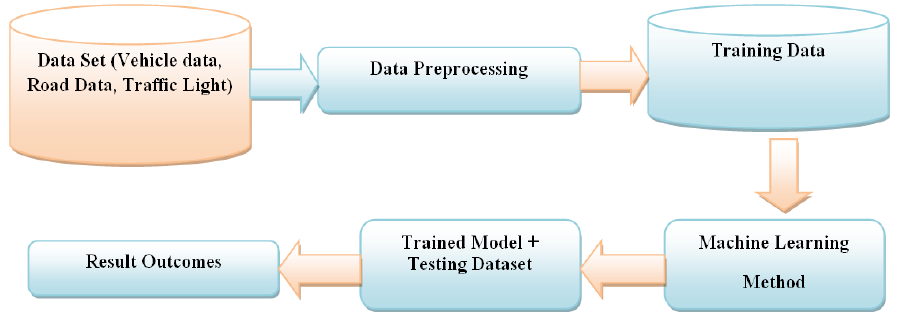
Figure 5. Vehicle location tracking process in ITM (using DBSCAN Clustering method). Algorithm 3: The proposed ATM model utilizes the machine-learning-based DBSCAN clustering method. This method deceived the MATLAB traffic simulator results and clusters into detecting any accidental anomalies. Algorithm 3: DBSCAN (D a , minimum_points, epsilon) // Detection of a vehicle collision on the road